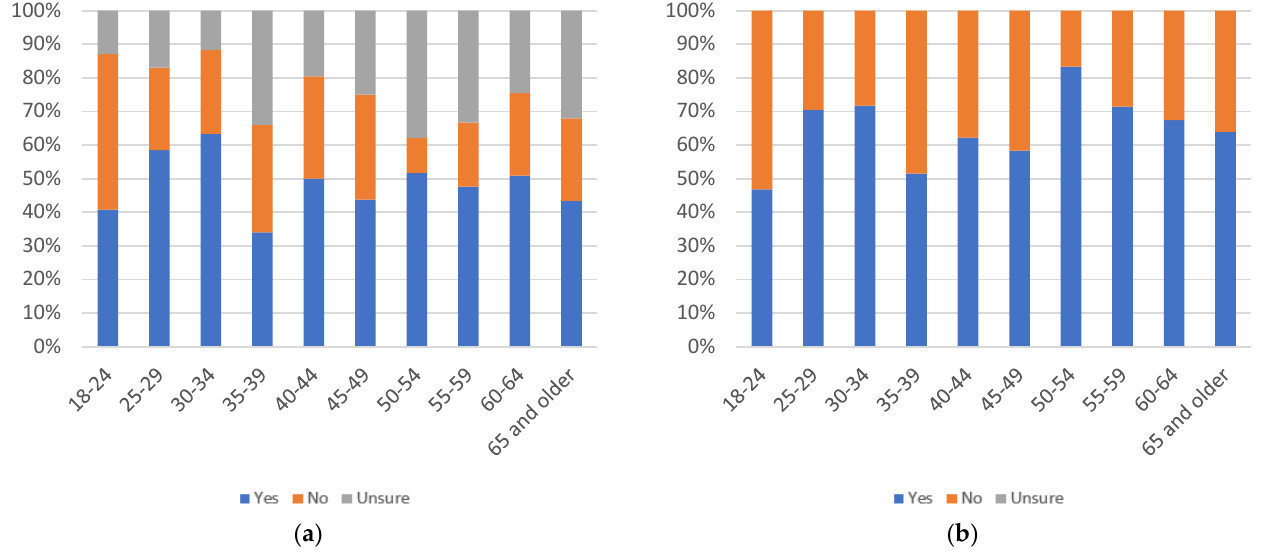
Figure 94. Label others’ use, by age group: ( a ) with uncertain respondents (left) and ( b ) without uncertain respondents (right).